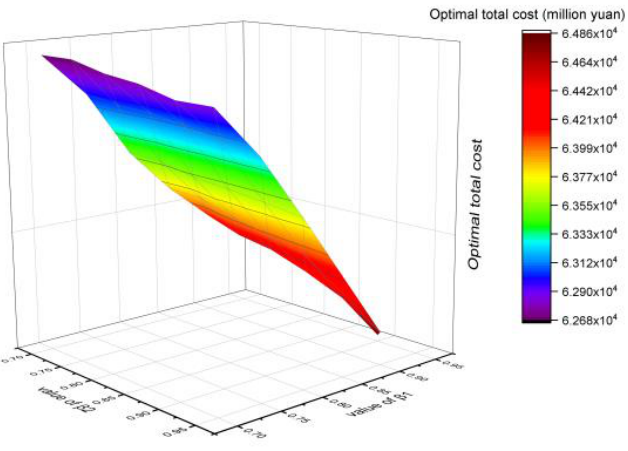
Figure 9. Optimal total cost versus values of β 1 and β 2 .